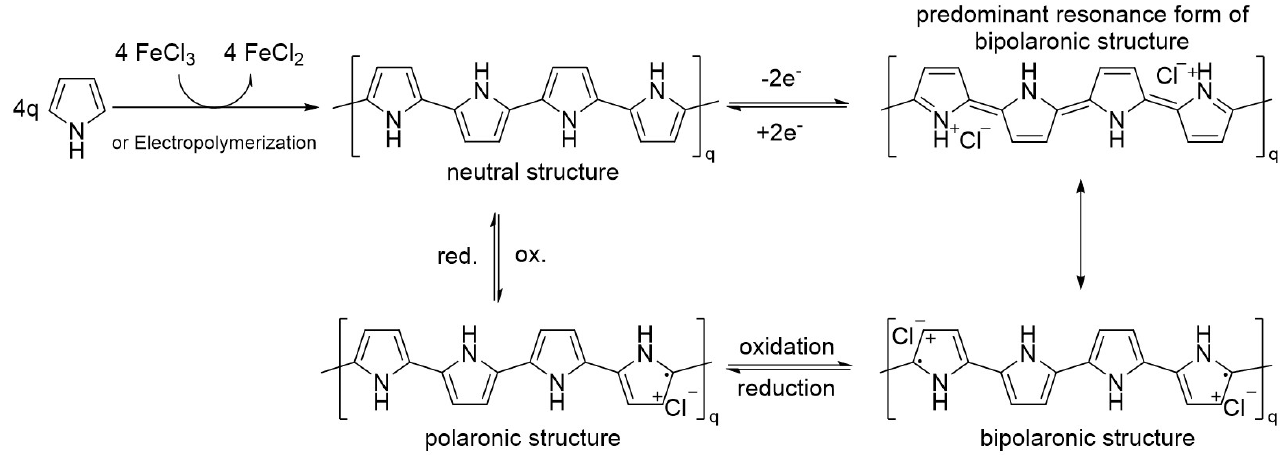
Figure 2. Pyrrole polymerization reaction, further redox equilibria and their resonance.